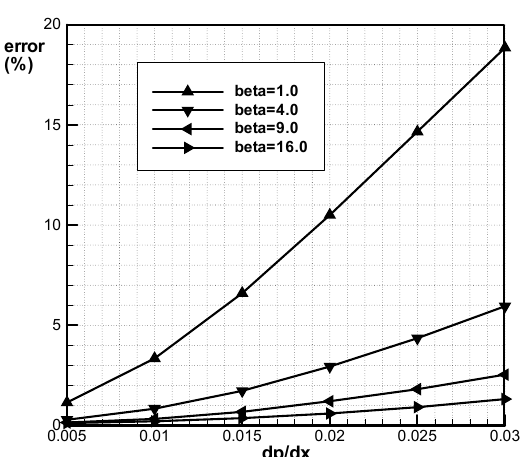
Fig.3 The relative velocity error at the middle of the channel for Poiseuille flow against various pressure